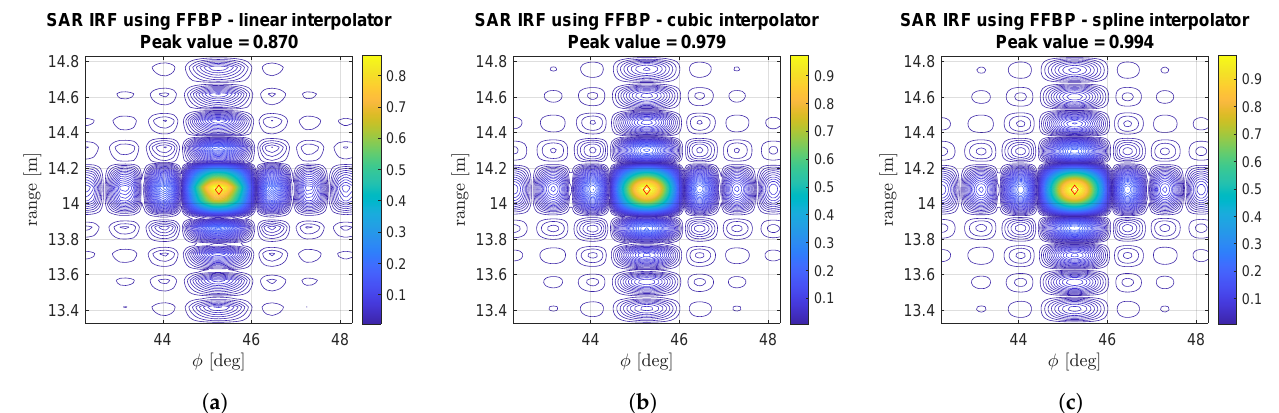
Figure 10. A s = 18 cm. SAR ImpulseResponse Function (IRF) generated by FFBP on a very fine polar grid centered in the nominal position of the target. The higher the order of the interpolator, the better the image in terms of peak value and